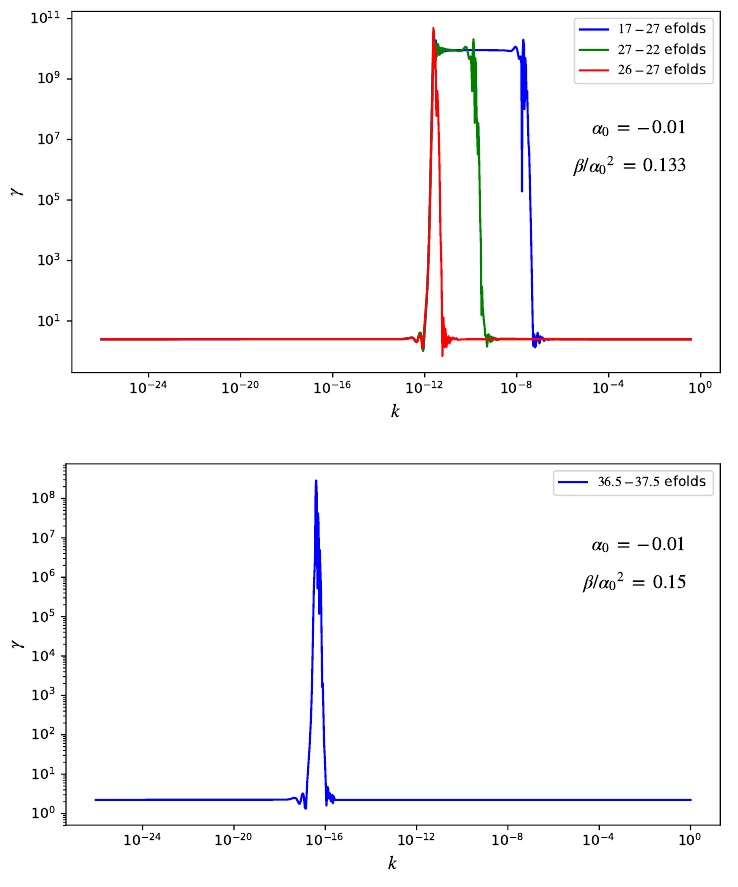
Figure 3 . The upper figure illustrates the generic behavior of the modulating factor, γ . In these three different plots, we have fixed N 1 = 30 and put N 2 = 20 , 25 , 29 for blue, green, and red lines, respectively. The delay parameter δn is almost the same in all these plots and turns out to be about 3 e-folds. In the lower figure, the enhancement occurs in scales k = e − 37 . 5 H − e − 36 . 5 H would lead to the formation of PBHs with a mass about 30 M (cid:12)